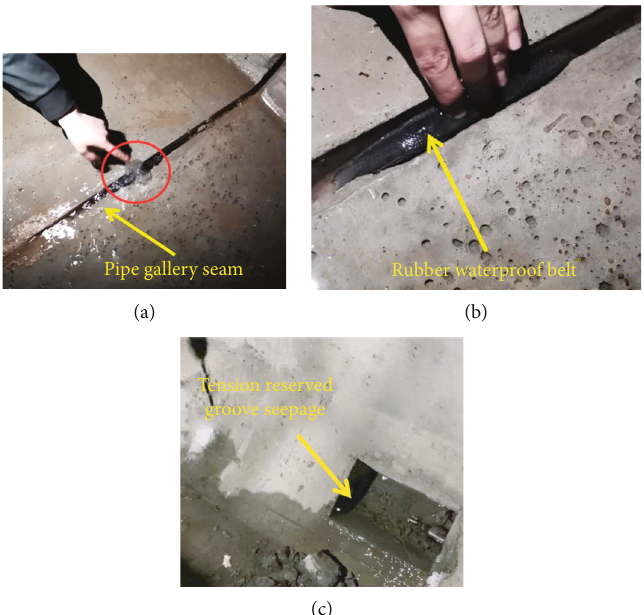
Figure 19: Serious water seepage in the integrated pipe gallery. (a) Water leakage at joints of integrated pipe gallery. (b) The rubber waterproof belt is bounced out. (c) Serious water seepage in the reserved groove for the tensioning of the pipe